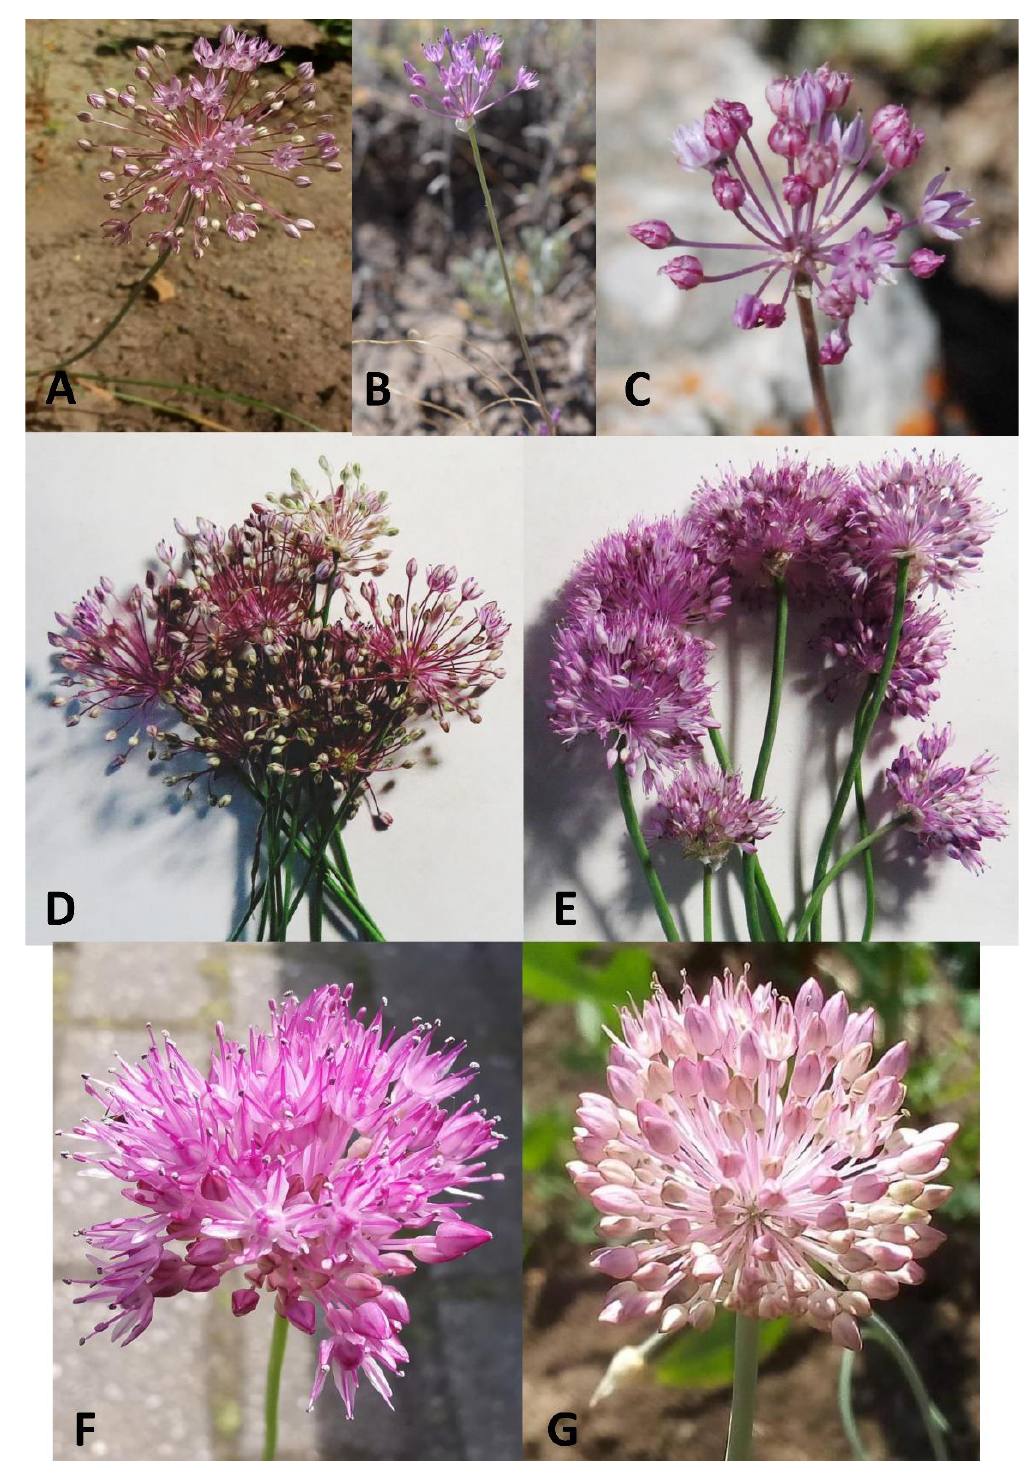
Figure 4. Inflorescences of the Allium pallasii : ( A ) — Am588 (Photo S. Smirnov); ( B ) — Am780; ( C ) – Am189; ( D ). Am607; Allium caricifolium : ( E ) — Am708 ; ( F ) — Am580; ( G ) — Am494. (All photos, except Am588, by N. Friesen, origin of the accessions in Appendix A). Accessions Am607 ( D ) and Am708 ( E ) were used to determine relative DNA amount.